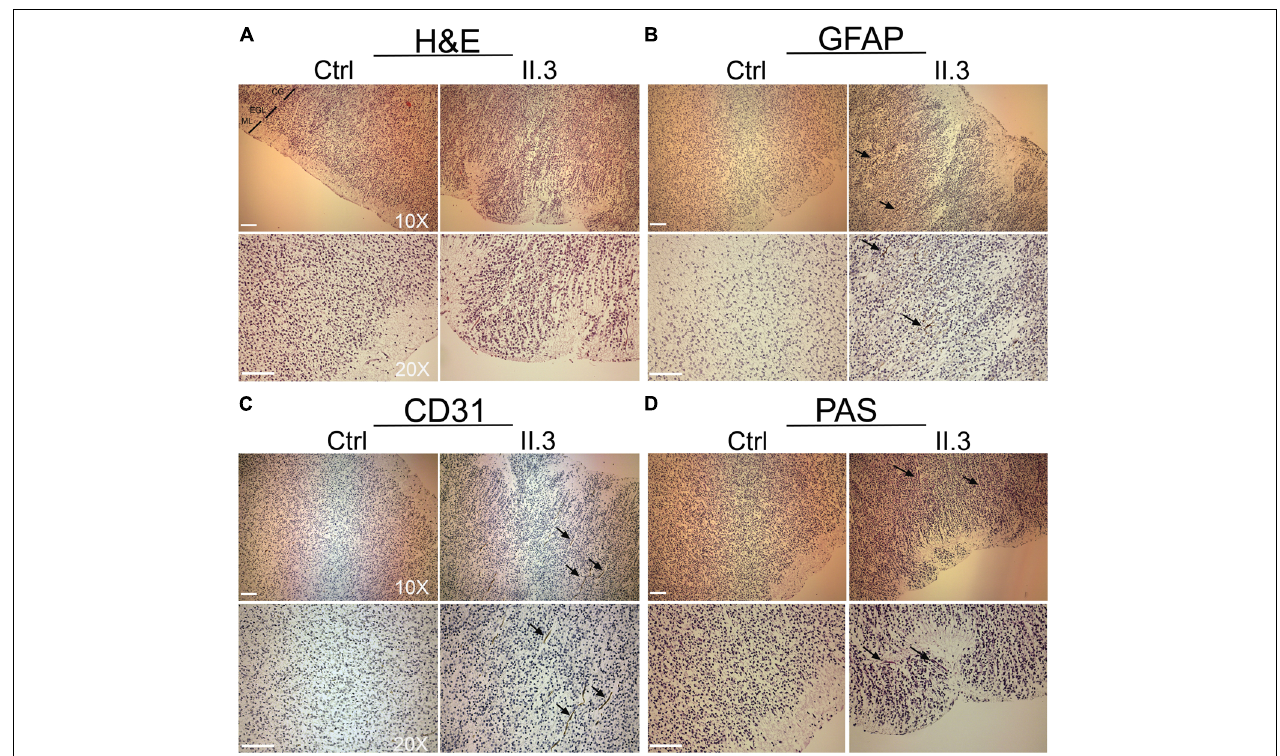
FIGURE 2 | Histopathological studies of WWOX -deficient human brain. (A) H&E staining shows an incorrect migration of the external granular layer within the molecular layer in patient II.3 (right panel) compared to a normal fetus (left panel) at the same gestational age. Images at 10X and 20X magnification (molecular layer: ML, external granular layer: EGL, cortical gray: CG). Scale bar: 50 µ m. (B) Histological staining with GFAP 10 × (upper panel) and 20 × (lower panel) in which a disorganization of the irregularly distributed trajectories is observed (black arrows). Scale bars: 50 µ m. (C) Histological staining with CD-31 at 10 × (upper panel) and 20 × (lower panel), in which thinning of the vessels is observed in the context of the external granular layer (black arrows). (D) Histological staining with Shift Reactive Periodic Acid (PAS) at 10 × (upper panel) and 20 × (lower panel) show that the vascular structures of the cortex are irregularly distributed and irregularly branched (black arrows). Scale bars 50 µ